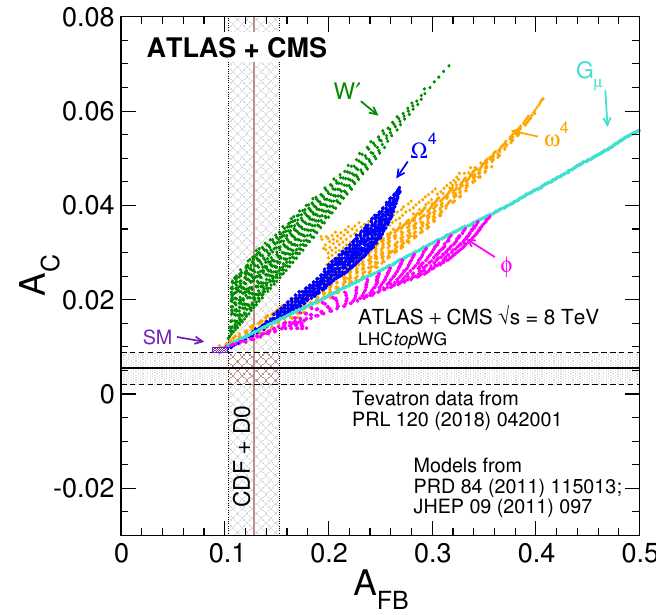
p s = 8 TeV (horizontal line)